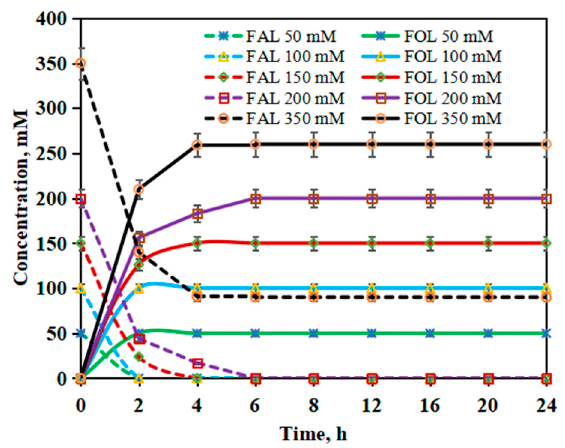
Figure 11. Biological reduction of 50–350 mM FAL into FOL with SF whole cells, NADP + (1 mmol NADP + /mol FAL), and glucose (1.5 mol glucose per mol FAL) in ChCl:PEG10000–water (pH 7.0, 35 °C).